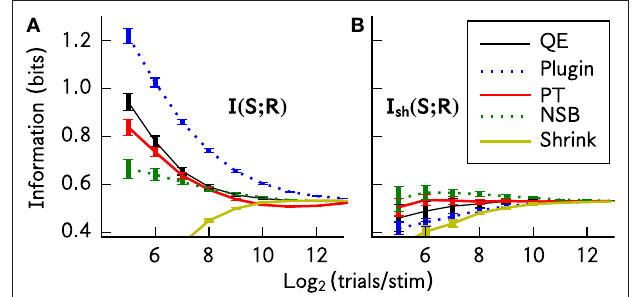
FIGURE 1 | Comparison of the performance of different bias correction methods. The methods were applied to spike trains of eight simulated somatosensory cortical neurons (see text). The information estimates I ( S ; R ) and I ( S ; R ) are plotted as a function of the available number of trials per sh stimulus. (A) Mean ± SD/2 (over 50 simulations) of I ( S ; R ). (B) Mean ± SD/2 (over 50 simulations) of I ( S ; R ). This calculation is very similar to that in sh Panzeri et al. (2007, Figure 3 ), which also used realistic simulations of cortical spike trains (the only difference was that for this fi gure, the simulated population did not contain any correlations). This fi gure was produced using the Python library for bias corrections described in Section “A Python Library for Information Theoretic Estimates”, and the code to produce it is available at